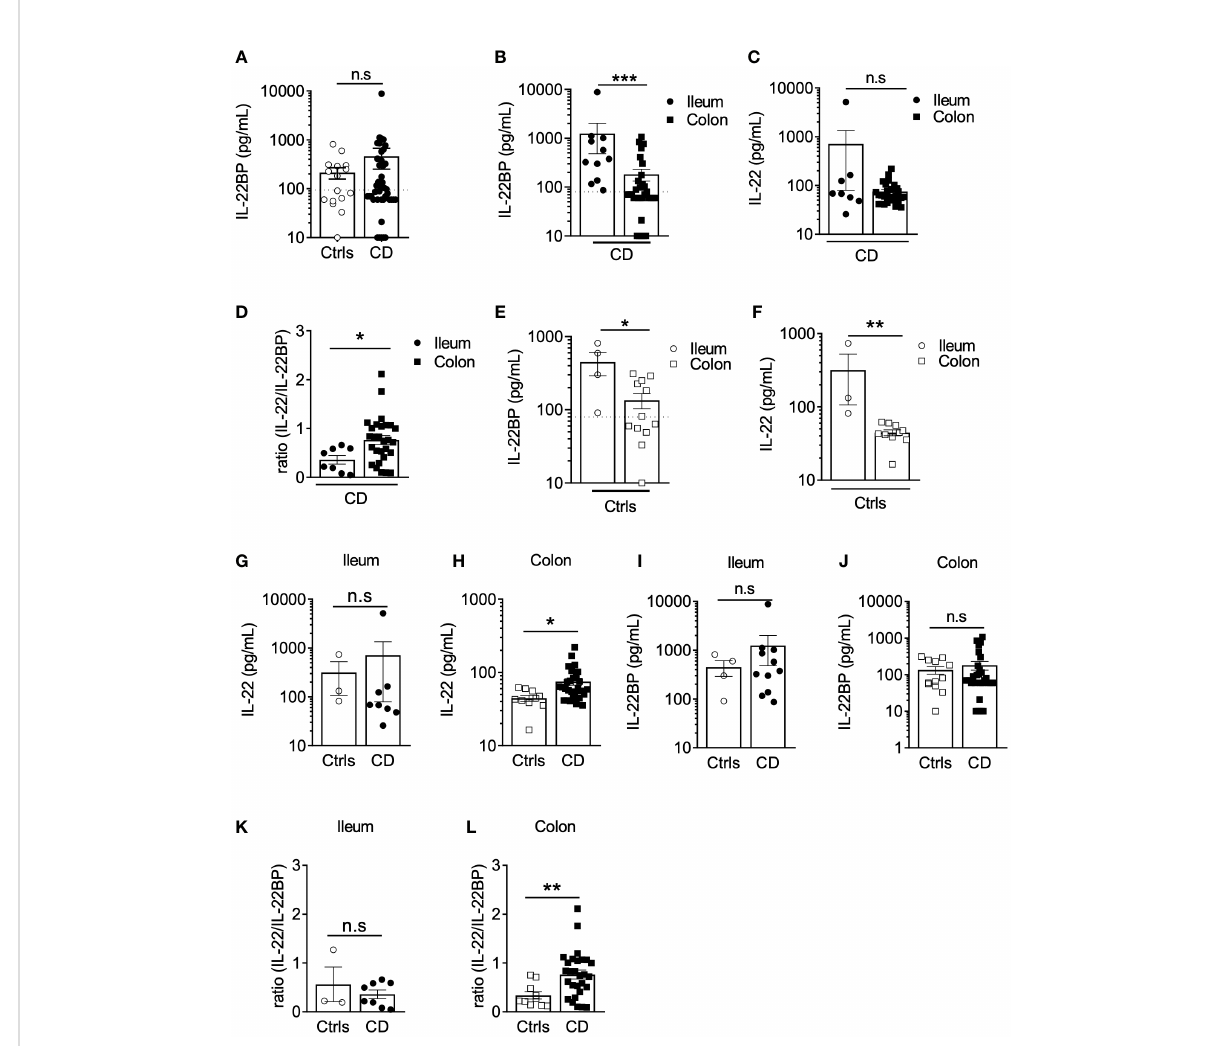
FIGURE 1 IL22BP levels are higher in the ileum than in the colon of Crohn ’ s disease patients. (A) Levels of soluble IL-22BP were quanti fi ed by ELISA in the supernatant of gut (both ileum and colon locations) endoscopic biopsies from controls (Ctrls) (n=16) and Crohn ’ s disease (CD) (n=43) patients after 6 hours of ex vivo culture. (B, C) Quanti fi cation of soluble IL-22BP (B) and IL-22 (C) in culture supernatants of biopsies from CD patients with in fl amed lesions in the ileum (n=11) or in the colon (n=32). (D) Comparison of IL-22/IL-22BP ratios in the supernatants of CD patients with in fl amed ileum and colon. (E, F) Quanti fi cation of soluble IL-22BP (E) and IL-22 (F) levels in the supernatant of gut biopsies from Ctrls ileum (n=4) and colon (n=12). (G, H) Comparison of IL-22 levels in the ileum (G) and the colon (H) of Ctrls and CD patients. (I, J) Comparison of IL-22BP levels in the ileum (I) and the colon (J) of Ctrls and CD patients. (K, L) Comparison of IL-22/IL-22BP ratios in the ileum (K) and the colon (L) of Ctrls and CD patients. Statistical signi fi cance for mean comparisons was assessed by the Mann-Whitney U-test in a two-sided manner, using a nominal signi fi cance threshold of P< 0.05. *P < 0.05, **P < 0.01, ***P < 0.001 ns, not signi fi